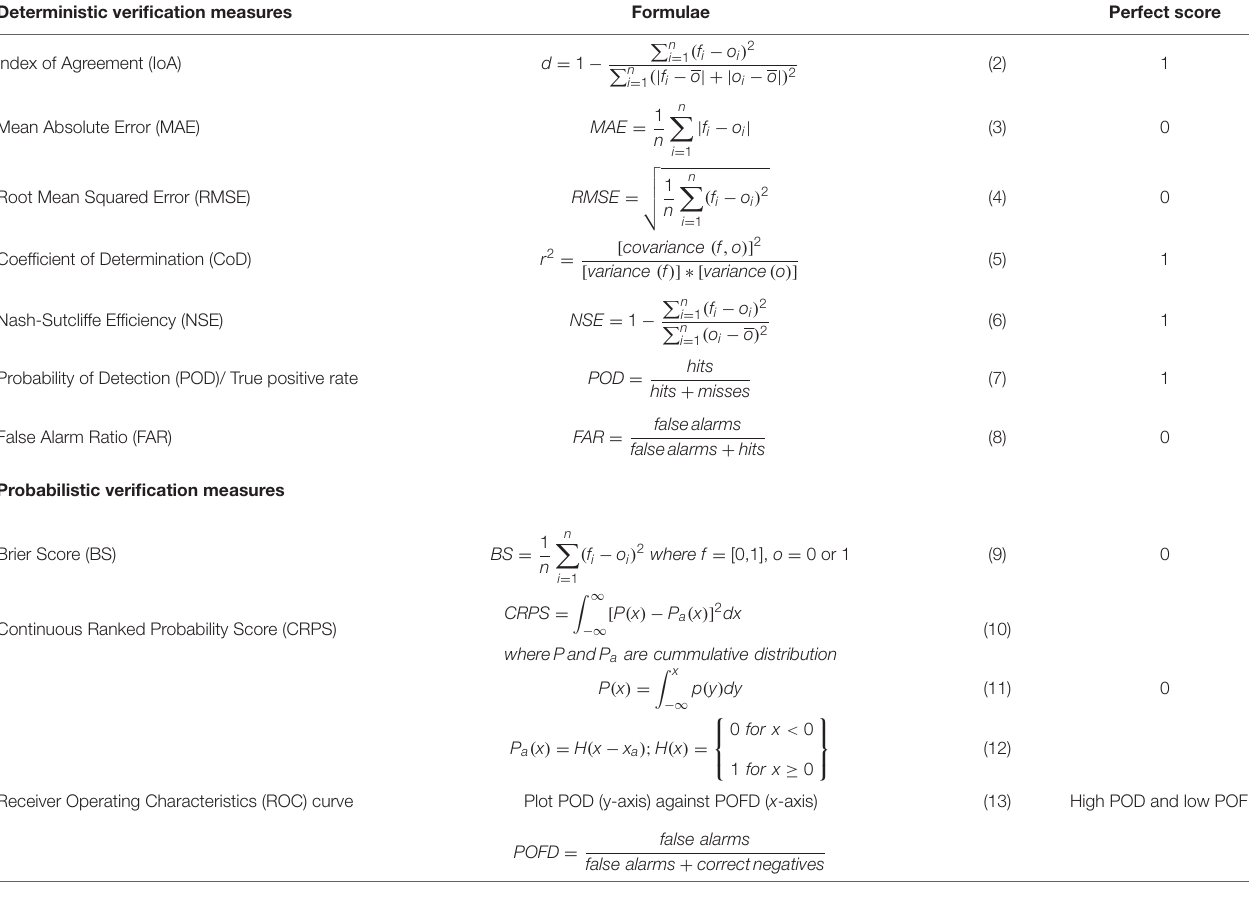
TABLE 2 | Deterministic and probabilistic verification measures and formulae ( f and o represent the model output and observed values respectively). Deterministic verification measures Formulae